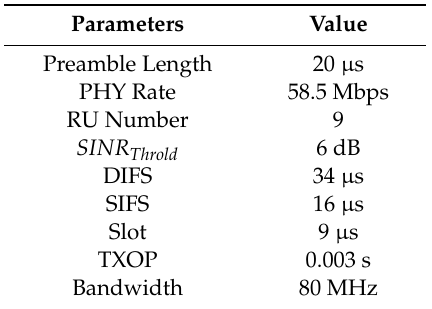
Table 2. Network parameter